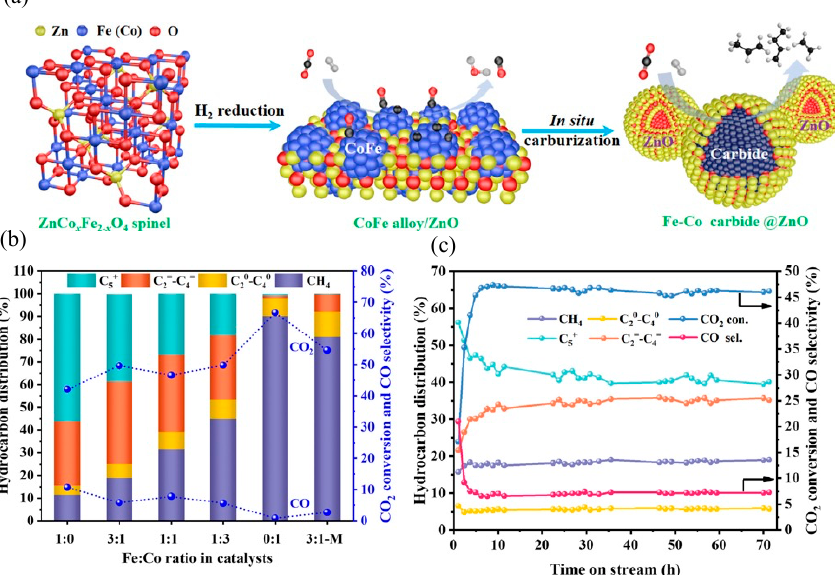
Figure 13. ( a ) Schematic illustration of the structural transformations of as-formed ZnCo x Fe 2-x O 4 catalysts during the reduction and reaction steps. ( b ) CO 2 conversion and product distributions over K-containing ZnCo x Fe 2-x O 4 catalysts with various Fe/Co molar ratios. ( c ) The stability of the K-containing ZnCo 0.5 Fe 1.5 O 4 catalyst in CO 2 hydrogenation (testing conditions: T = 583 K, P = 2.5 MPa,